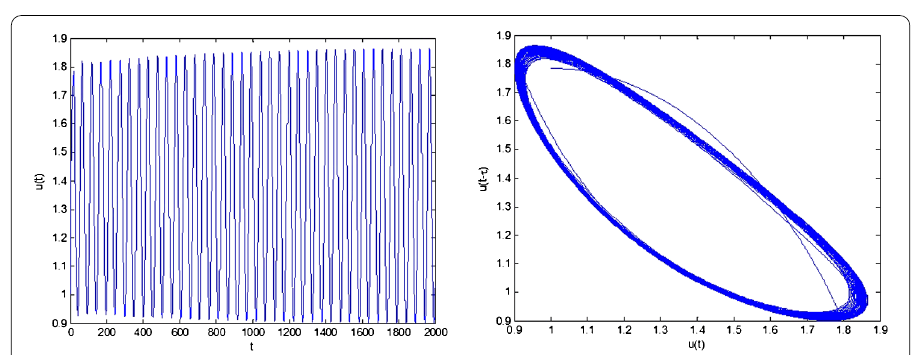
Figure 2 Waveform plot and phase portrait of the fractional-order model (2.7) with α = 0.92, m = 0.2, and the initial value u 0 = 1. A Hopf bifurcation occurs and the periodic oscillation bifurcates from u ∗ , where υ = 21 > υ 0 = 19.6749.